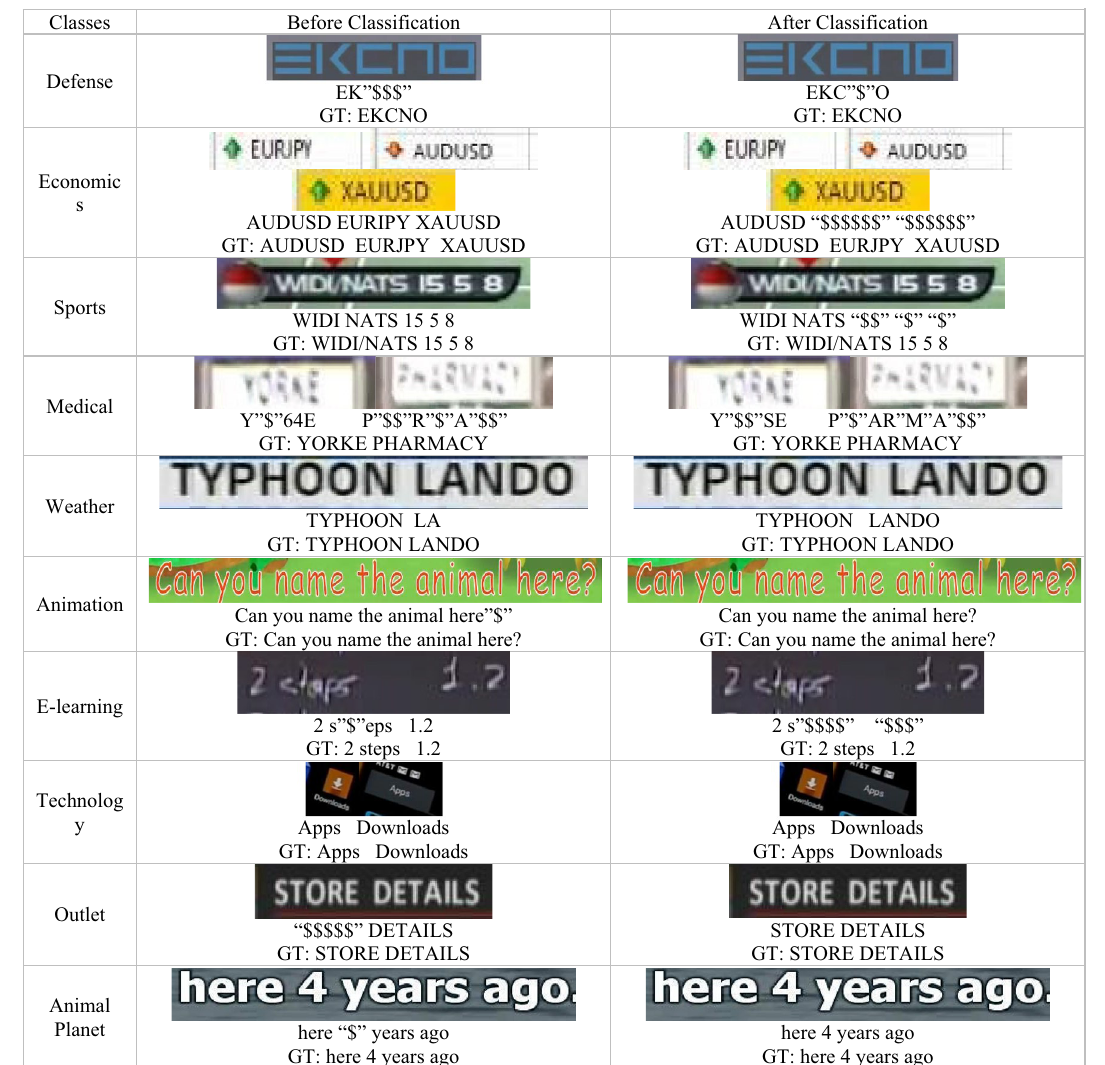
Fig. 12 Qualitative results of the recognition method on STD dataset before and after classification. GT denotes ground truth, “$” denotes recognition method gives